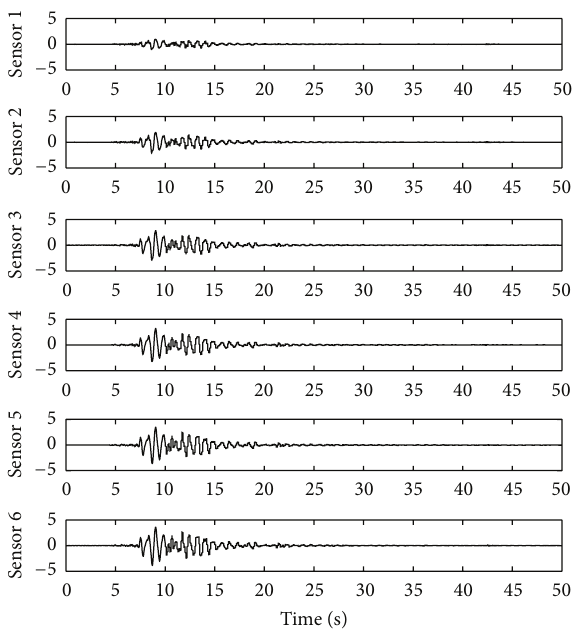
Figure 2: Acceleration sensor responses.